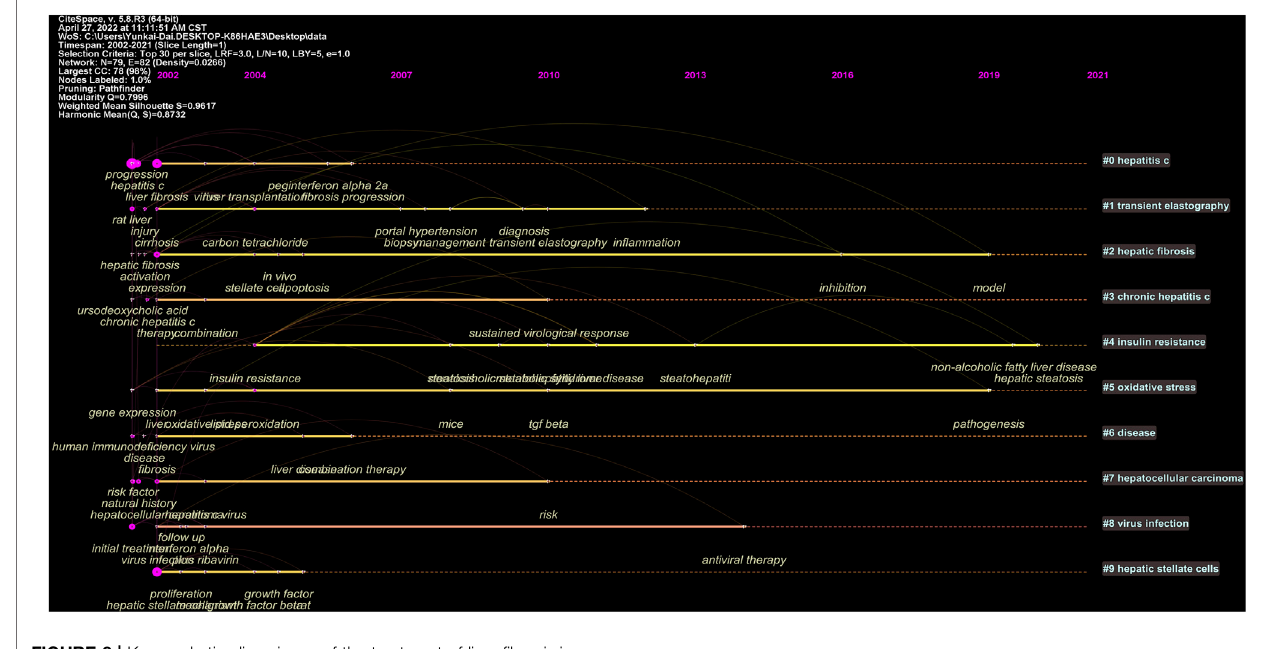
FIGURE 8 | Keywords timeline viewer of the treatment of liver fi